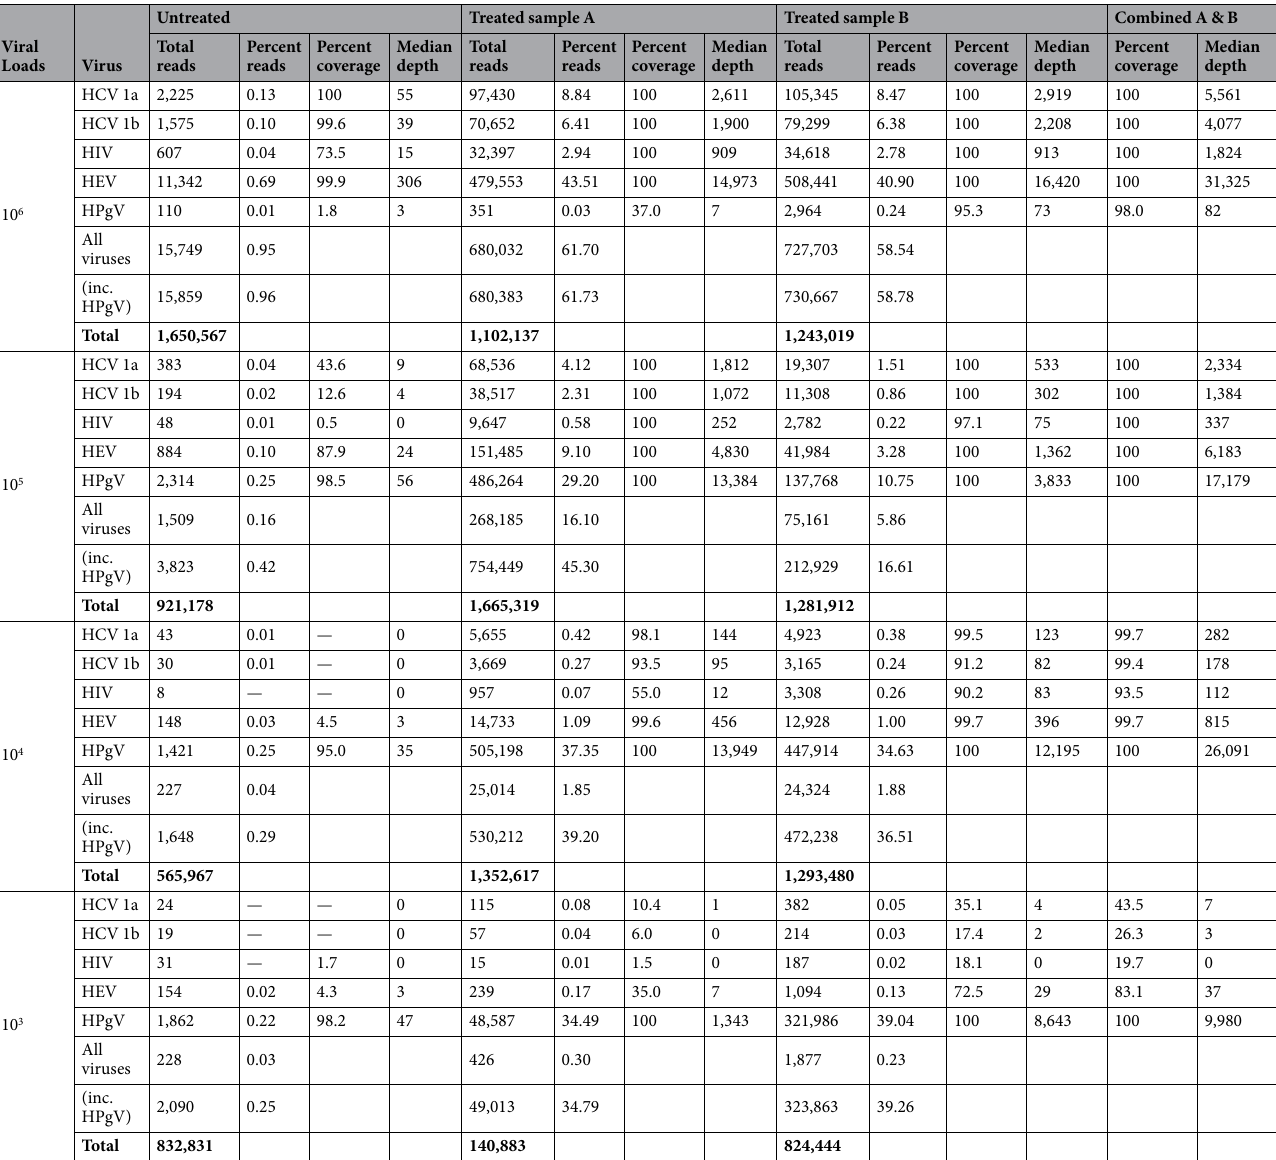
Table 3. Detailed sequencing data from the BBV Panel. For each of the three samples (Untreated, A and B) at each dilution (10 6 –10 3 ), the number and percentage of reads mapping to each virus are given, together with the genome coverages (depth ≥ 10) and median depths. The final column gives these last two metrics from the combined data sets of both the A and B samples. Included in the analysis are data for the HPgV discovered in the sample